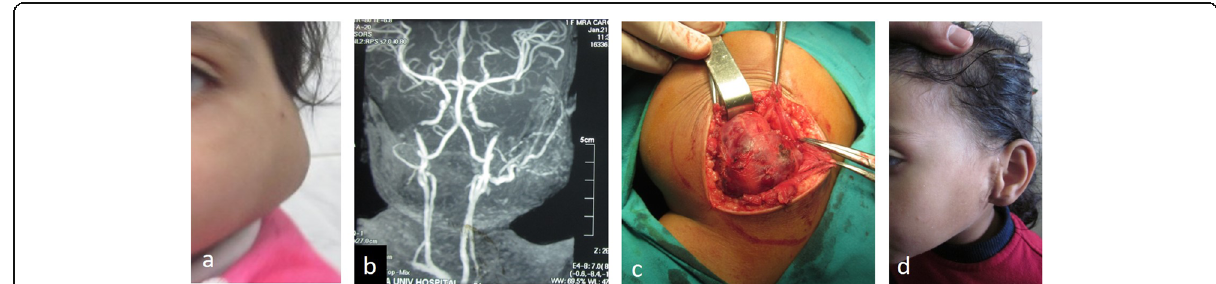
Fig. 8 a Infantile haemangioma in the left parotid of a 12-month-old girl. Failure to respond to medical treatment was an indication for excision at the age of 3 years. b MR angiography showing the feeding artery that was embolized by interventional radiologist 24 h before surgery to decrease bleeding during operation. c Care should be given to avoid fascial nerve injury during operation. d Outcome after excision of parotid haemangioma